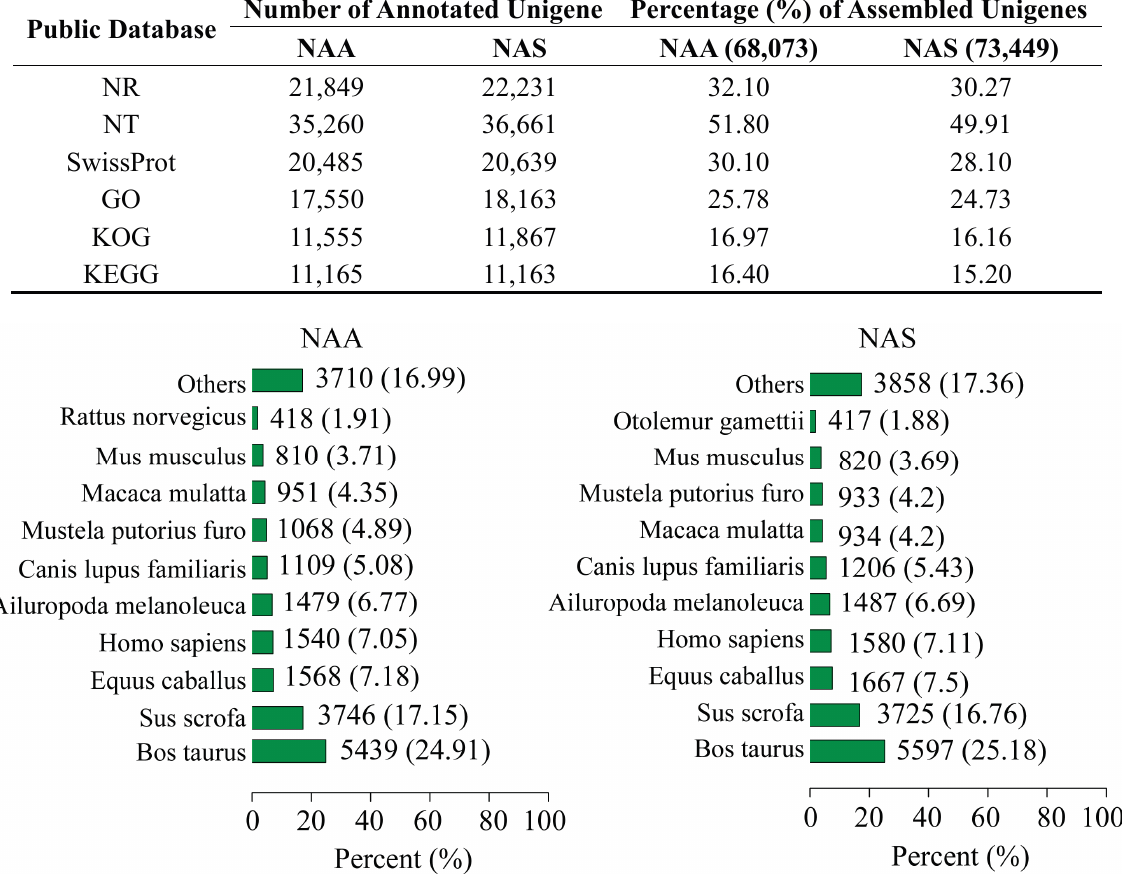
Table 2. Summary of unigenes annotated in important public databases. NAA: the Yangtze finless porpoise; NAS: the East Asian finless porpoise.